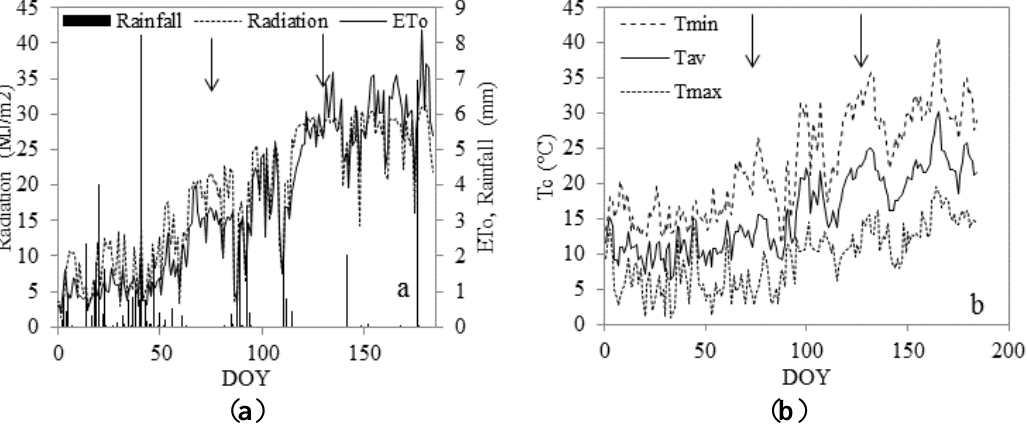
Figure 4. ( a ) Temporal evolution of ETo (mm), solar radiation (MJ·m −2 ), and rainfall (mm) during the growing season; ( b ) Maximum, average, and minimum daily temperature (°C) for the same period. Arrows indicate the times of flights (on DOY 76 and